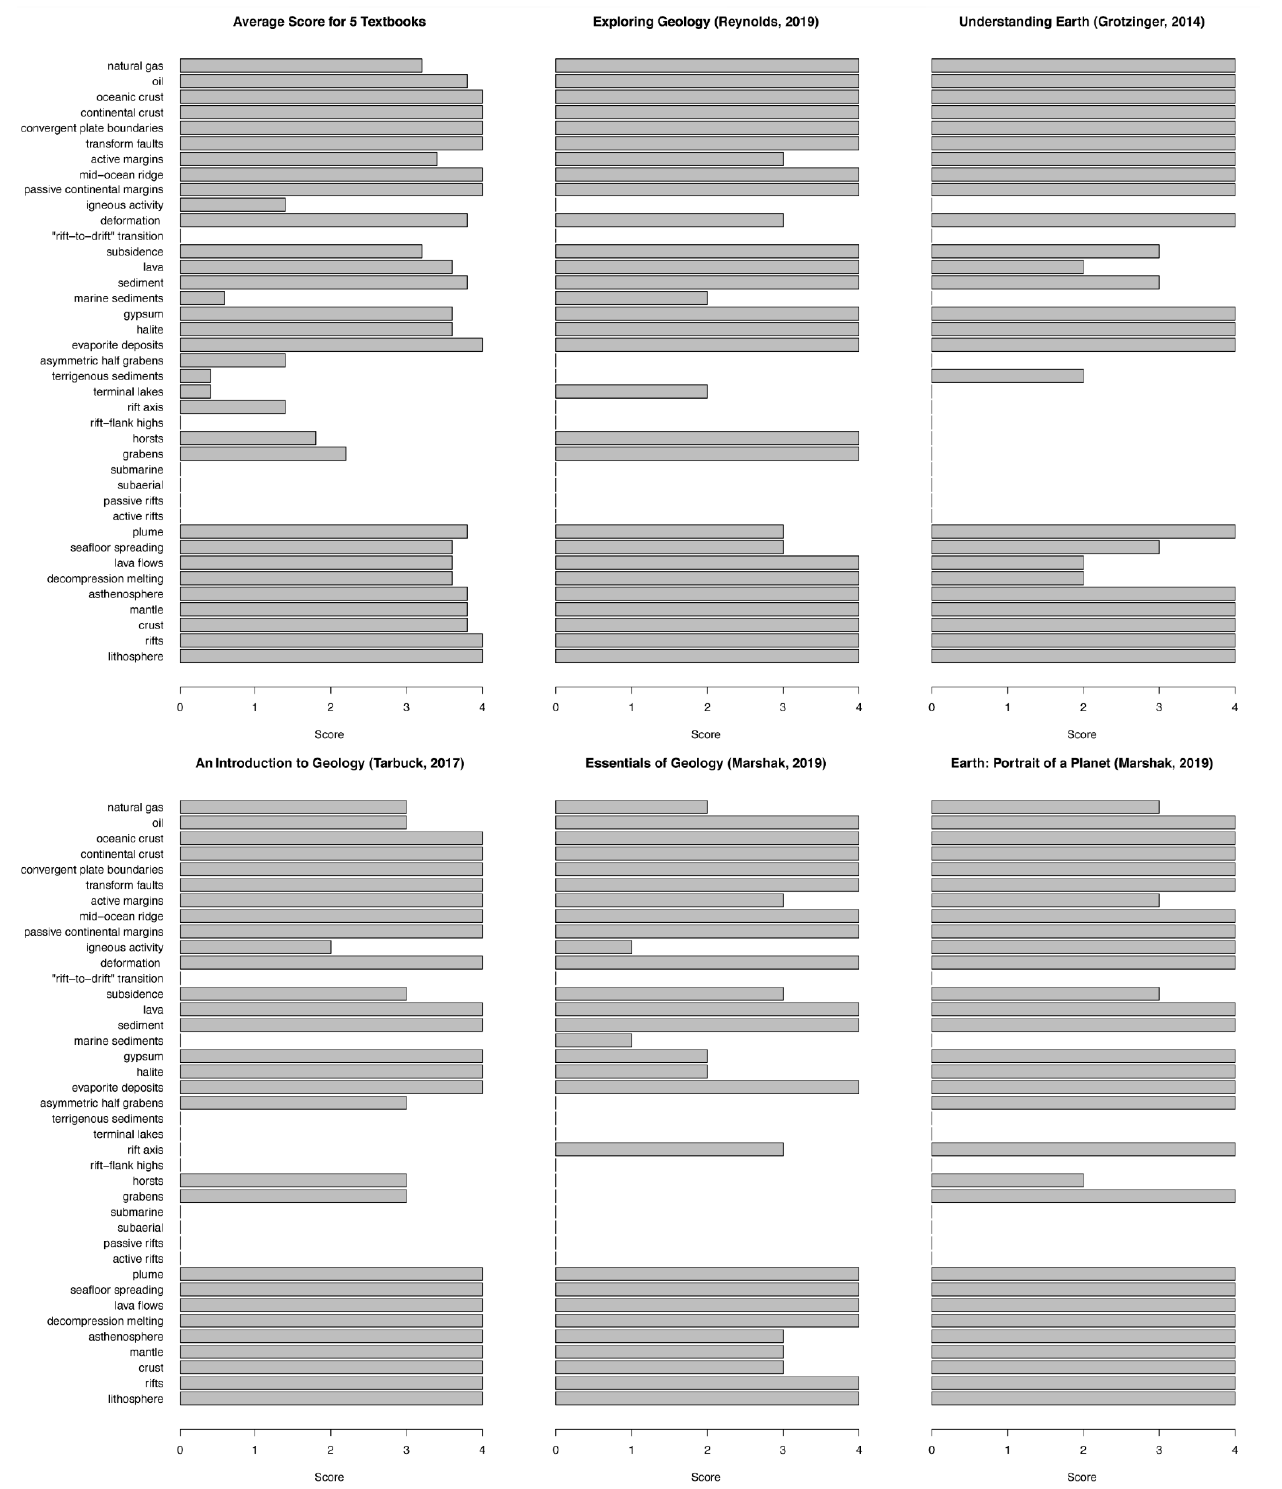
Figure 3. Textbook scores. Depicted are the results after evaluating five introductory physical geology textbooks to better understand the extent to which the 38 call-out terms from the upper-division rifting video are discussed. See text for further discussion.